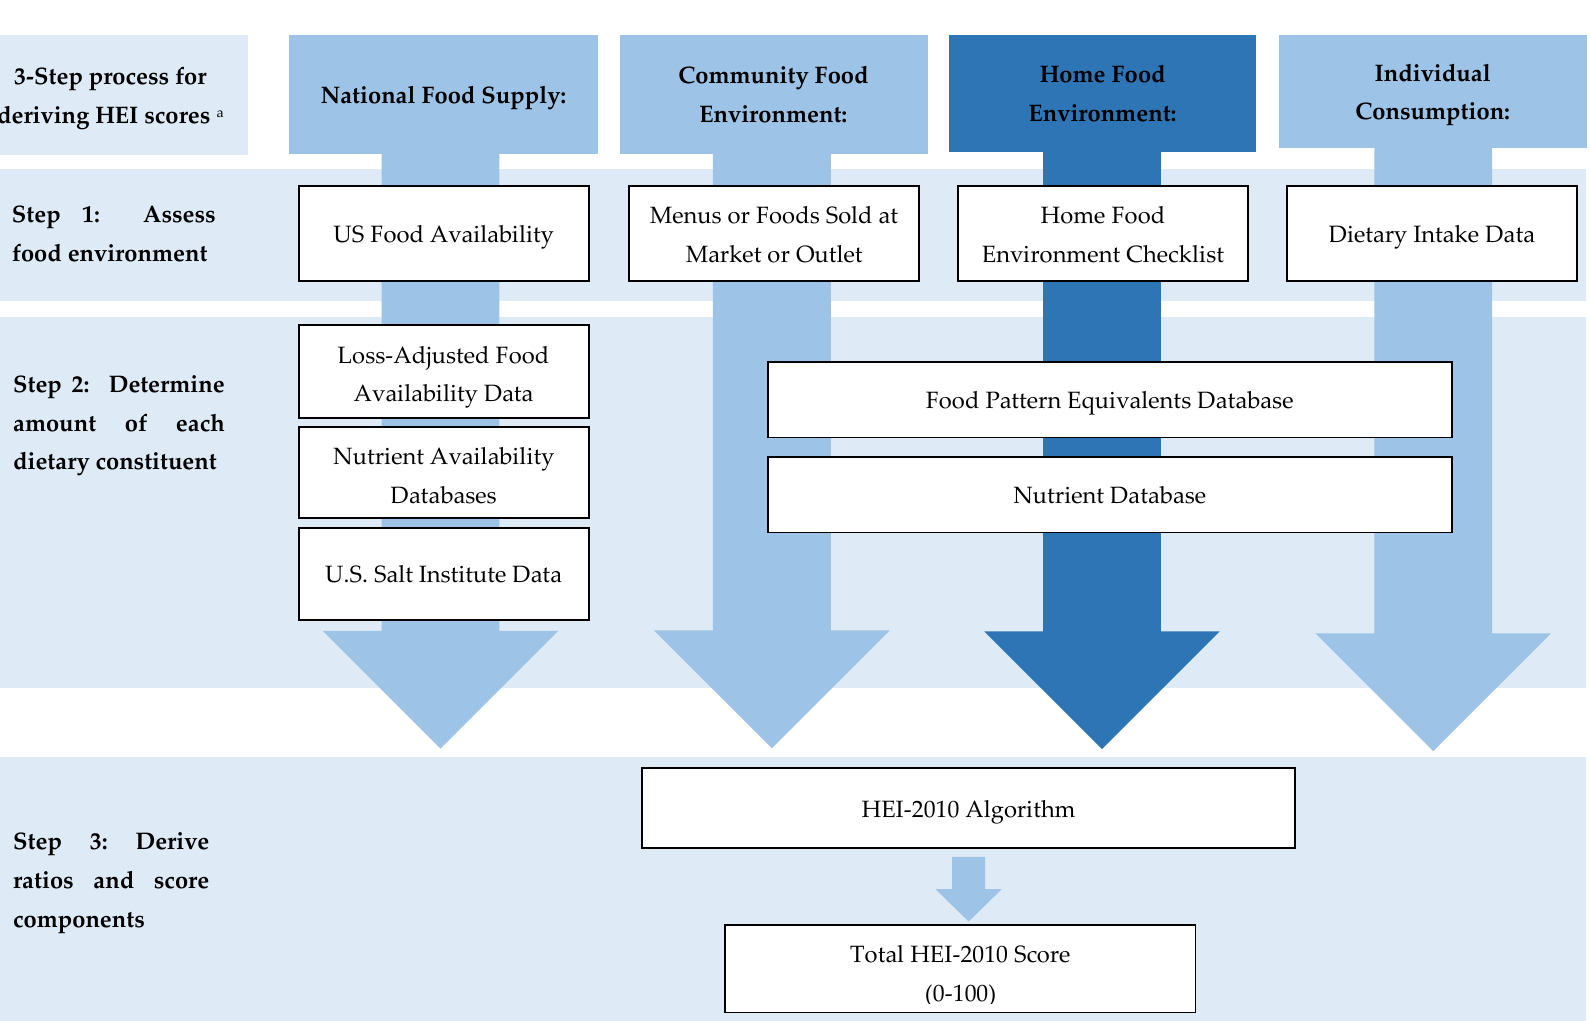
Figure 1. Three step process for deriving Healthy Eating Index (HEI) scores across different levels of the food system. a Figure adapted from Calculating HEI Scores at Different Levels, the HEI scoring illustration